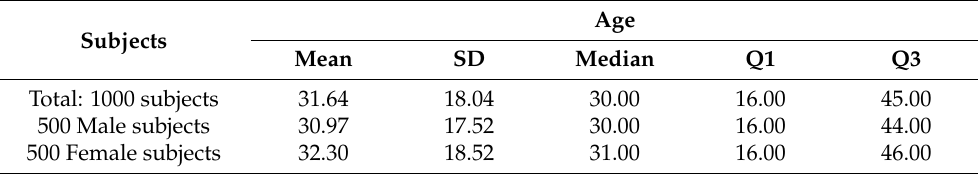
Table 1. Age information of